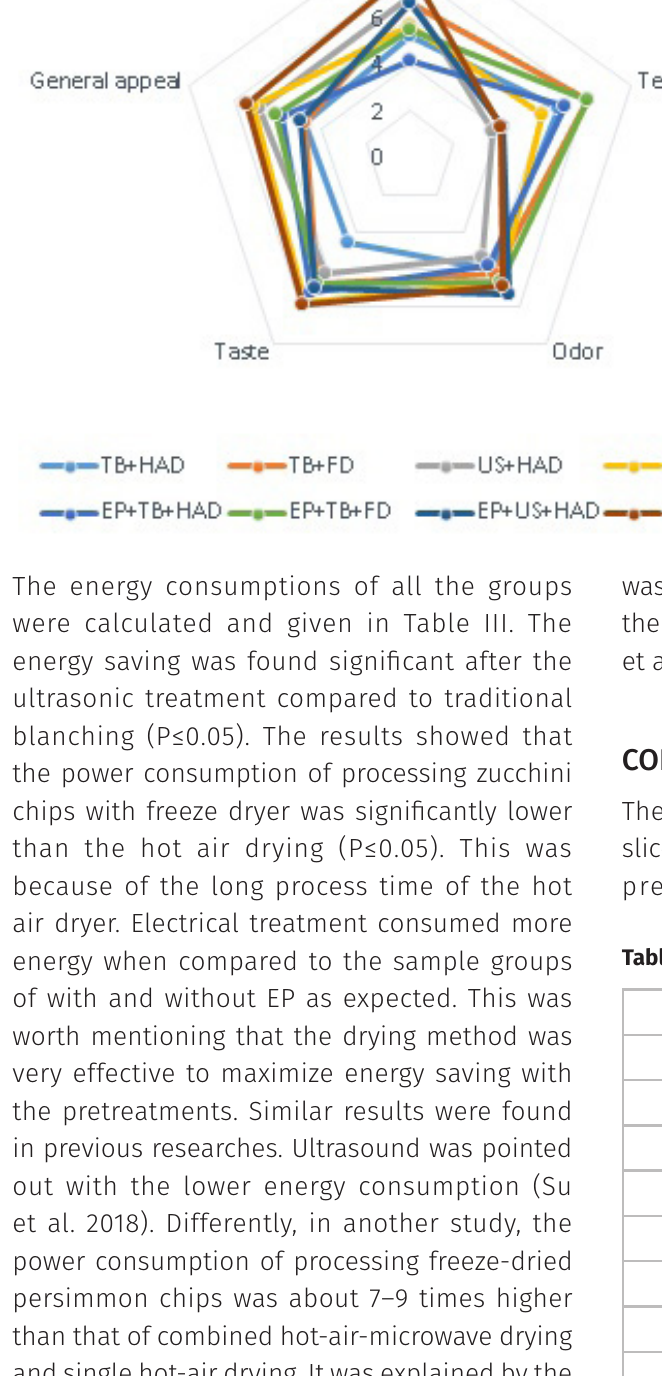
Figure 4. Radar chart of sensory evaluation of zucchini chips processed by different drying technique.